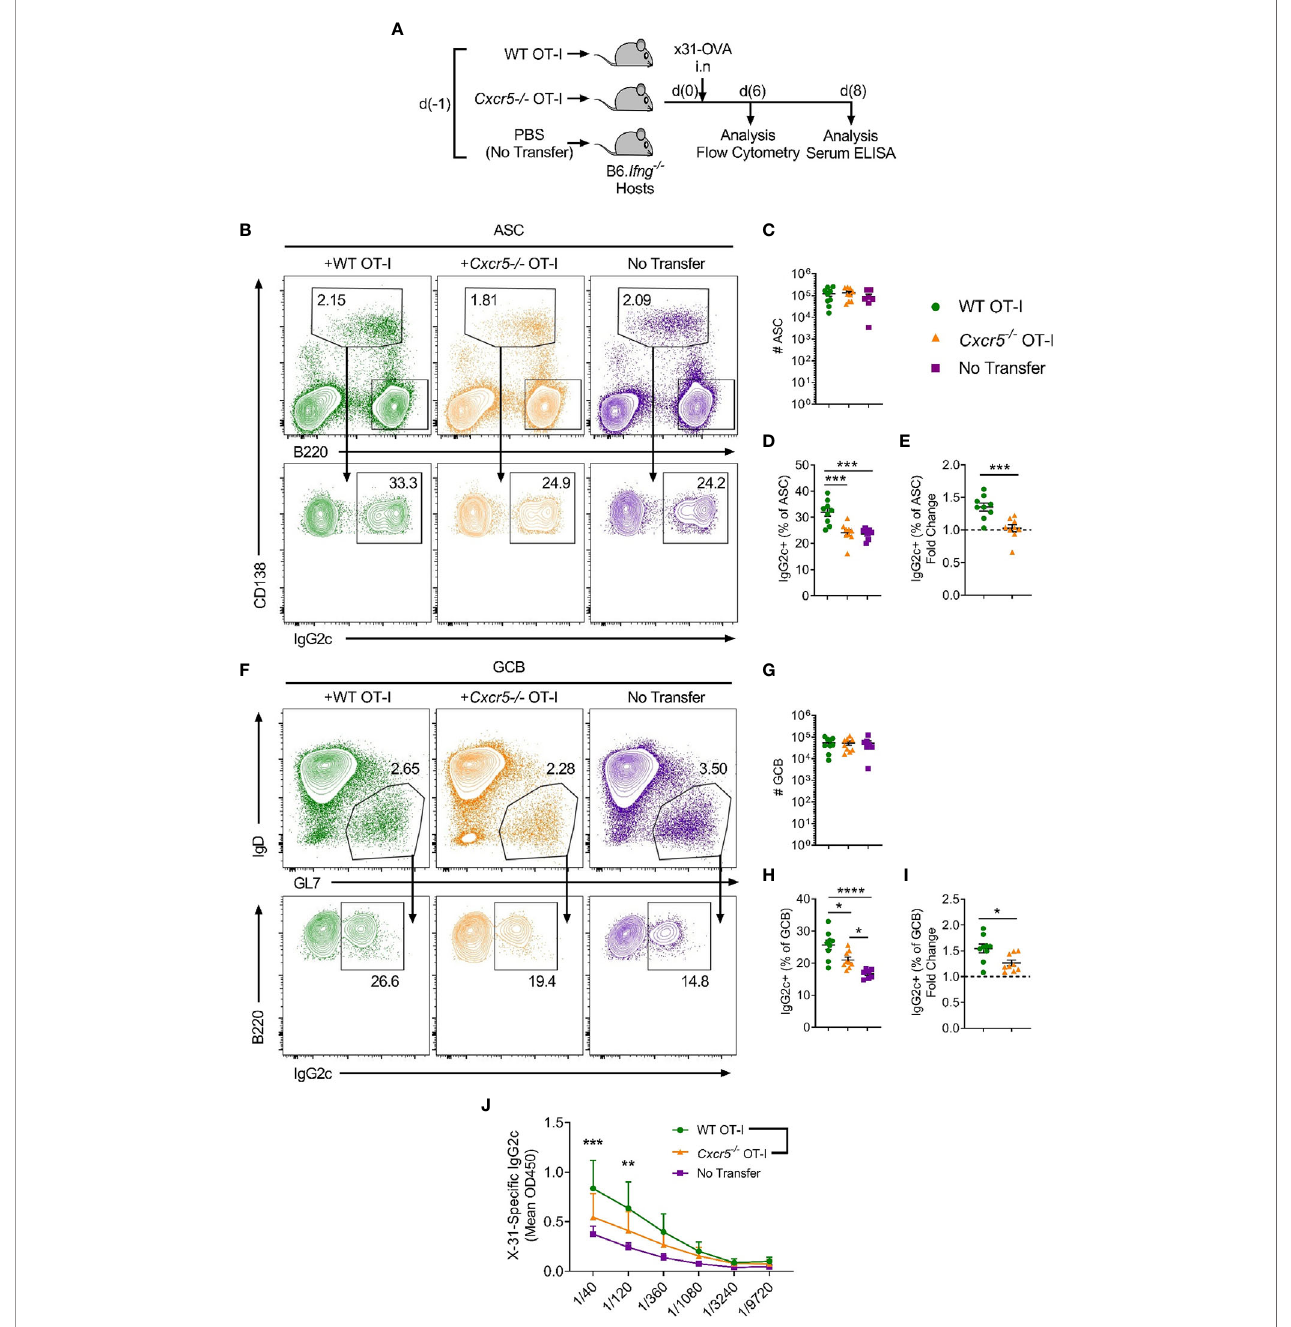
FIGURE 5 | CXCR5 + CD8 + T cells promote class switching to IgG2c in responding B cells following IAV infection. WT or Cxcr5 -/- OT-I cells (or PBS only for no transfer controls) were transferred i.v. into separate B6. Ifng -/- mice that were then infected with x31-OVA i.n. (A) Schematic outline of the experiment. (B) Gating strategy used for identi fi cation of CD138 + B220 int ASCs and IgG2c-switching in ASCs in the mLN. Cells in the top panel were pre-gated on live, single cells. (C) Quanti fi cation of ASC number. (D) Frequency of IgG2c + ASCs among total ASCs. (E) Fold change in IgG2c-induction relative to the no transfer control (dashed line). (F) Gating strategy used for identi fi cation of B220 + IgD - GL7 + GCB cells and IgG2c-switching in GCB cells in the mLN. Cells in the top panel were pre-gated on live, single, B220 + CD138 - cells. (G) Quanti fi cation of GCB cell number. (H) Frequency of IgG2c + GCB cells among total GCB cells. (I) Fold change in IgG2c- induction relative to the no transfer control (dashed line). (J) Levels of serum x31-speci fi c IgG2c on day 8 post-infection assessed by ELISA. (C – E, G – I) Data are pooled from two independent experiments with a total of 7-9 mice group or (J) representative of two independent experiments with 4-5 mice per group. (C – E, G – I) Data were analysed by ordinary one-way ANOVA or (J) two-way ANOVA with Bonferroni ’ s multiple comparison test. (C – E, G – I) Mean ± SEM or (J) Mean + SD. *p < 0.05, **p < 0.01, ***p < 0.001, ****p <